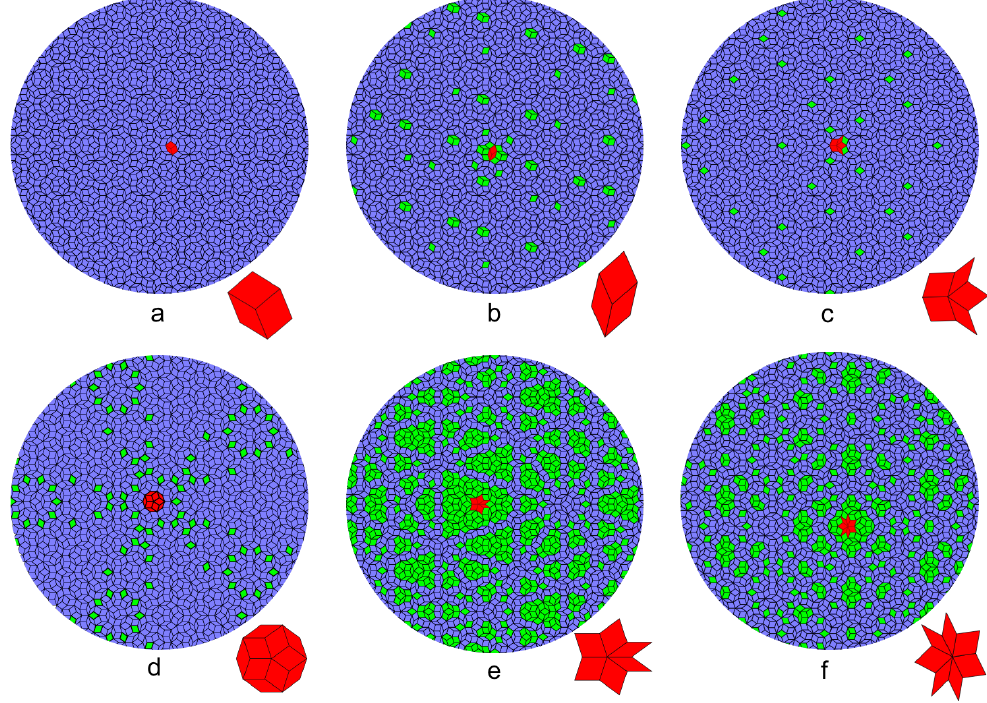
Figure 9. Results of the empire calculation for the rest of vertex types in Penrose tiling, using the multigrid method. For each vertex type, an enlarged center vertex configuration is shown at the lower right corner of its